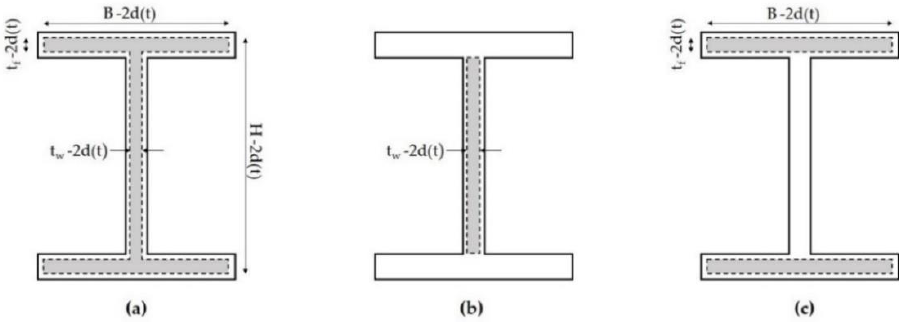
Figure 6. Schematic corrosion mass loss for: ( a ) entire section; ( b ) Web only; ( c ) flanges only.